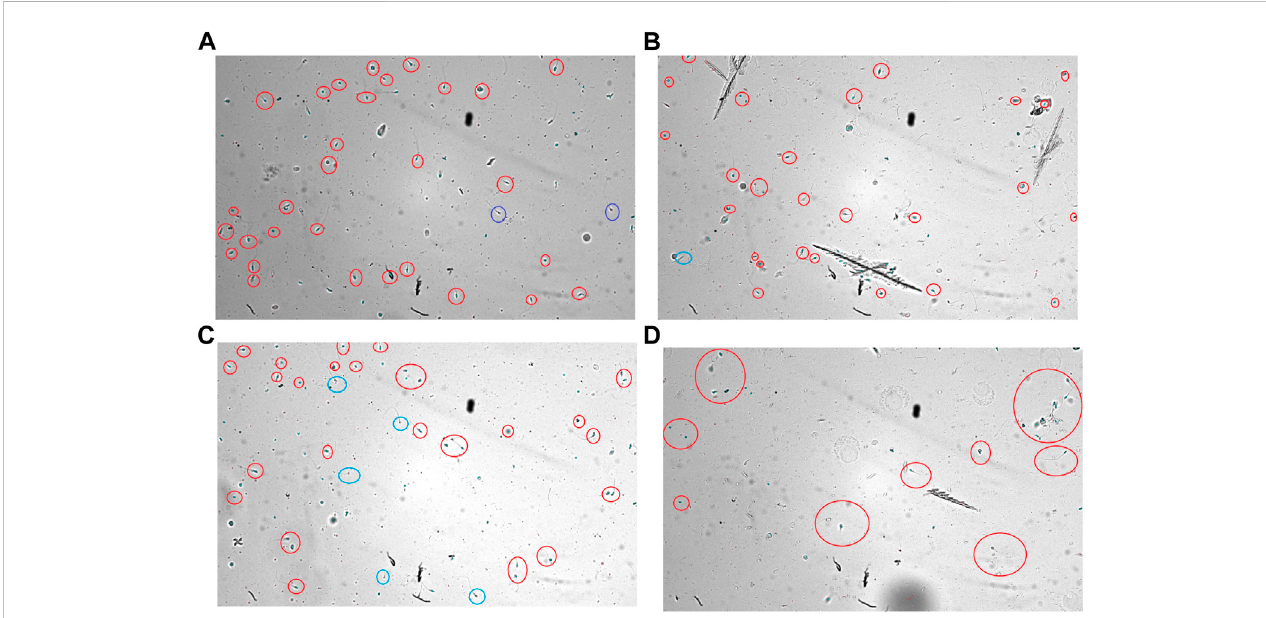
FIGURE 1 From left to right — Frames recorded from the CASA analysis of AMLE-added sperm cells using MMC software for (A) 100 μ g/ml AMLE (B) 1,000 μ g/ml AMLE (C) 10,000 μ g/ml AMLE (D) 1,00,000 μ g/ml AMLE. The blue circles generated by the software indicate a greater number of immotile cells. To highlight theimmotilesperm cells,wemanually highlightedthebluemarksusingredcircles. Thecellswithinthebluecirclemarkindicateacompleteloss ofspermcell